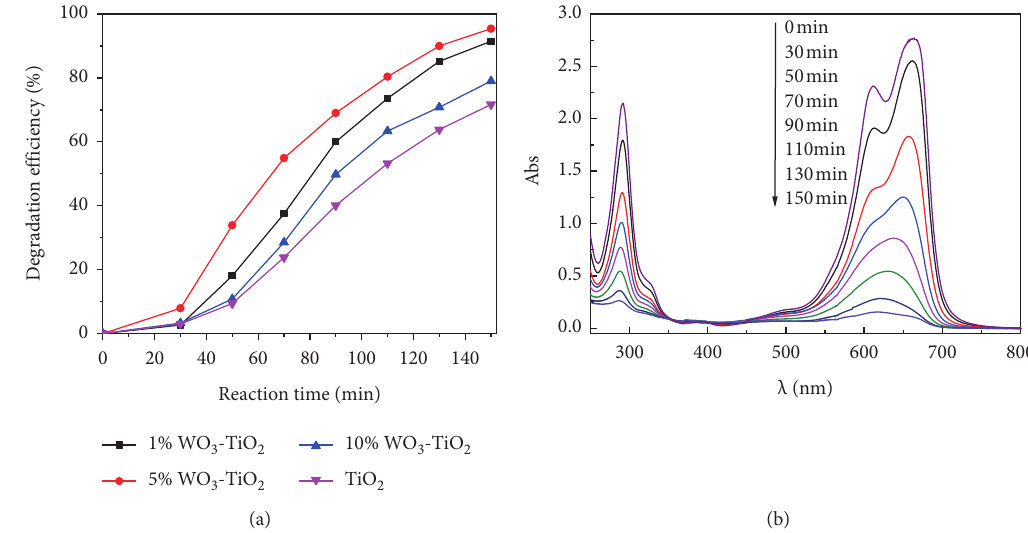
Figure 2: (a) Decomposition of MB by TiO 2 and WO 3 /TiO 2 nanofibers; (b) UV-Vis absorption spectra of MB during the photodegradation process by 5% WO 3 /TiO 2 nanofibers.